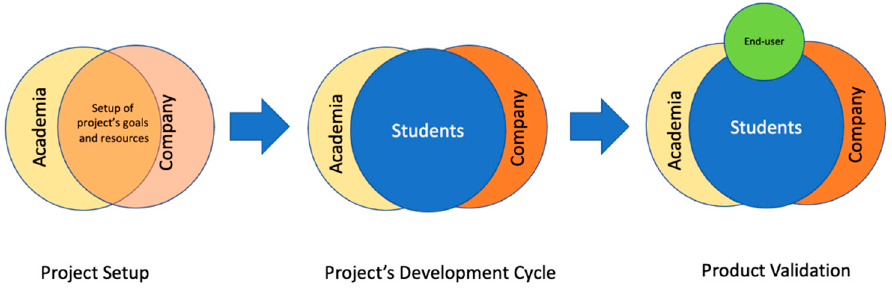
Figure 7. Collaborative evolution.